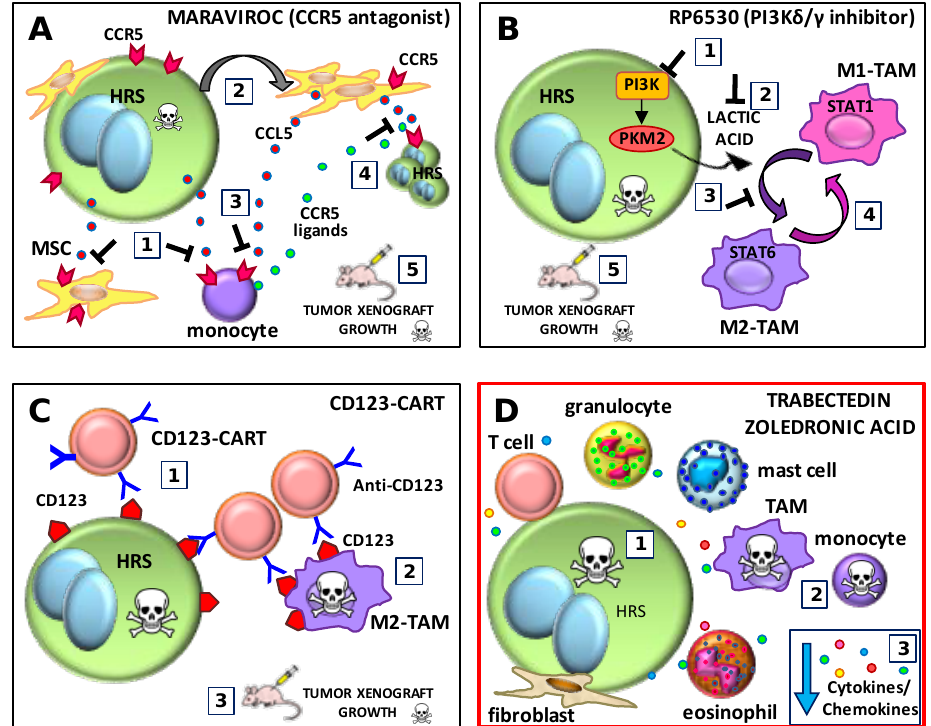
Figure 3. Proposed mechanism for the inhibitory effects of maraviroc, RP6530, chimeric antigen receptor T cells (CART)123, trabectedin and zoledronic acid on tumor cells and the tumor microenvironment (TME). ( A ) Maraviroc. (1) The C-C chemokine receptor type 5 (CCR5) antagonist maraviroc inhibits the recruitment of both monocytes and mesenchymal stromal cells (MSCs) by classic Hodgkin lymphoma (cHL) cells. (2) The education of MSCs cells (E-MSCs) induces the secretion of C-C motif ligand 5 (CCL5) (red dots). (3) Maraviroc inhibits the recruitment of monocytes by CCL5 secreted by E-MSCs. (4) Maraviroc inhibits cHL clonogenic growth promoted by CCR5 ligands (green dots) secreted by tumor-educated monocytes (E-monocytes) and E-MSCs (CCL5+). (5) Maraviroc decreases cHL tumor xenograft growth and monocyte infiltration.